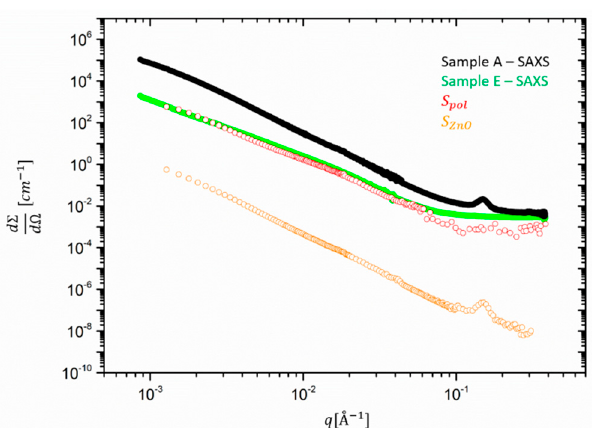
Figure 2. Partial structure factors S pol (red) and S ZnO (orange) as derived from sample A in comparison Figure 2. Partial structure factors 𝑆 (cid:3043)(cid:3042)(cid:3039) (red) and 𝑆 (cid:3027)(cid:3041)(cid:3016) (orange) as derived from sample A in comparison with absolutely calibrated SAXS data for samples A (black) and E (green). S pol was arbitrarily shifted to with absolutely calibrated SAXS data for samples A (black) and E (green). 𝑆 (cid:3043)(cid:3042)(cid:3039) was arbitrarily shifted be compared with sample Figure 2. Partial structure factors 𝑆 (cid:3043)(cid:3042)(cid:3039) (red) and 𝑆 (cid:3027)(cid:3041)(cid:3016) (orange) as derived from sample A in comparison to be compared with sample E. with absolutely calibrated SAXS data for samples A (black) and E (green). 𝑆 (cid:3043)(cid:3042)(cid:3039) was arbitrarily shifted to be compared with sample E.